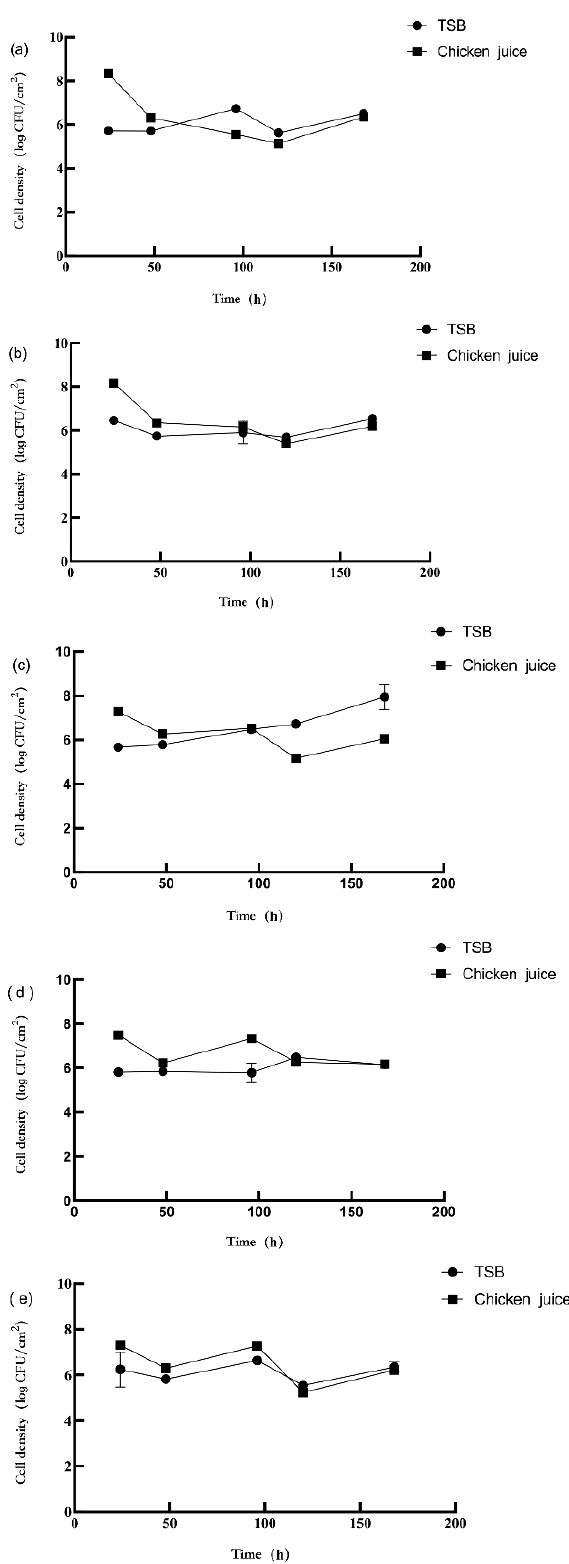
Figure 2. Biofilm formation of P. aeruginosa ( a – e ) in different incubation conditions. Note: The mono-species biofilms of P. aeruginosa with the initial inoculum concentration of 3 log CFU/mL ( a ) and 4 log CFU/mL ( b ); the dual-species biofilms of L. monocytogenes and P. aeruginosa with the ratio of 1:1 ( c ); 1:10 ( d ); and 10:1 ( e ).